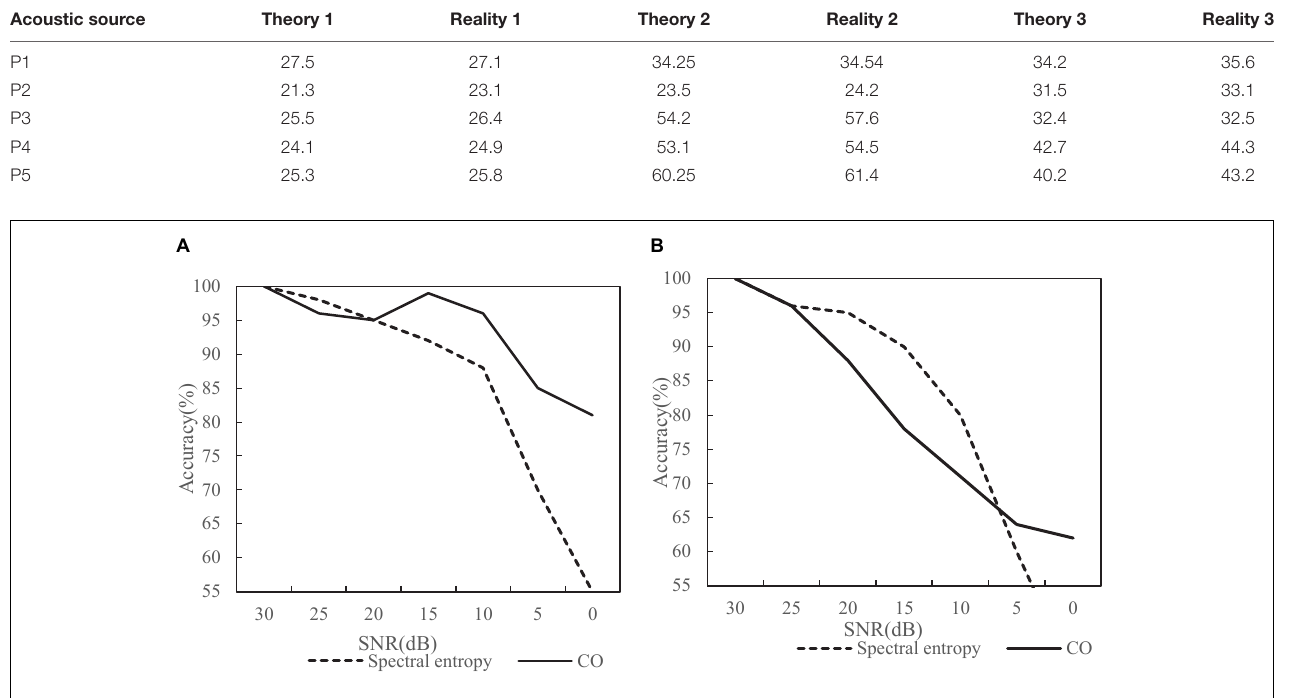
FIGURE 3 | Comparison of detection effects in different environments of speech endpoints. (A) Indoor environment. (B) Outdoor